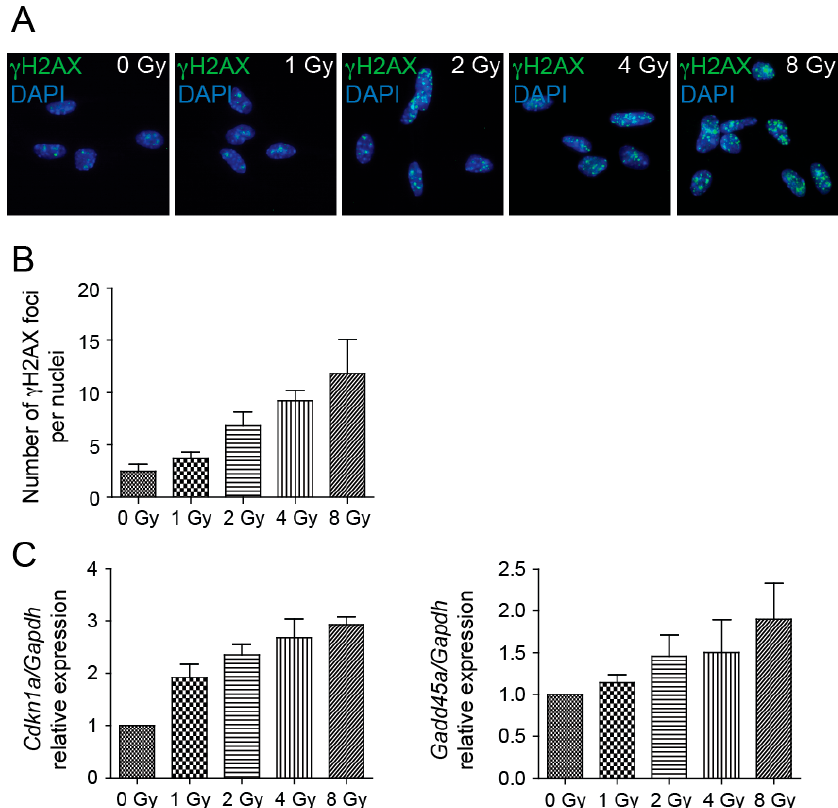
Figure 2. DNA damage response is induced by irradiation. ( A ) Representative immunofluorescence images of NSCs 4 h after irradiation to 0, 1, 2, 4, and 8 Gy doses stained with γ -H2AX antibody (green). DAPI (blue) was used to stain the nuclei. Original magnification: 400 × . ( B ) Quantification of γ -H2AX nuclear foci 4 h after irradiation to 0, 1, 2, 4, and 8 Gy doses. Mean values: 0 Gy-2.49, 1 Gy-3.67, 2 Gy-6.82, 4 Gy-9.24, 8 Gy-11.82; p = 0.0002. ( C ) Quantitative RT-PCR analysis of mRNA levels of Cdkn1a and Gadd45a genes 4 h after irradiation to 0, 1, 2, 4, and 8 Gy doses. Gapdh was used